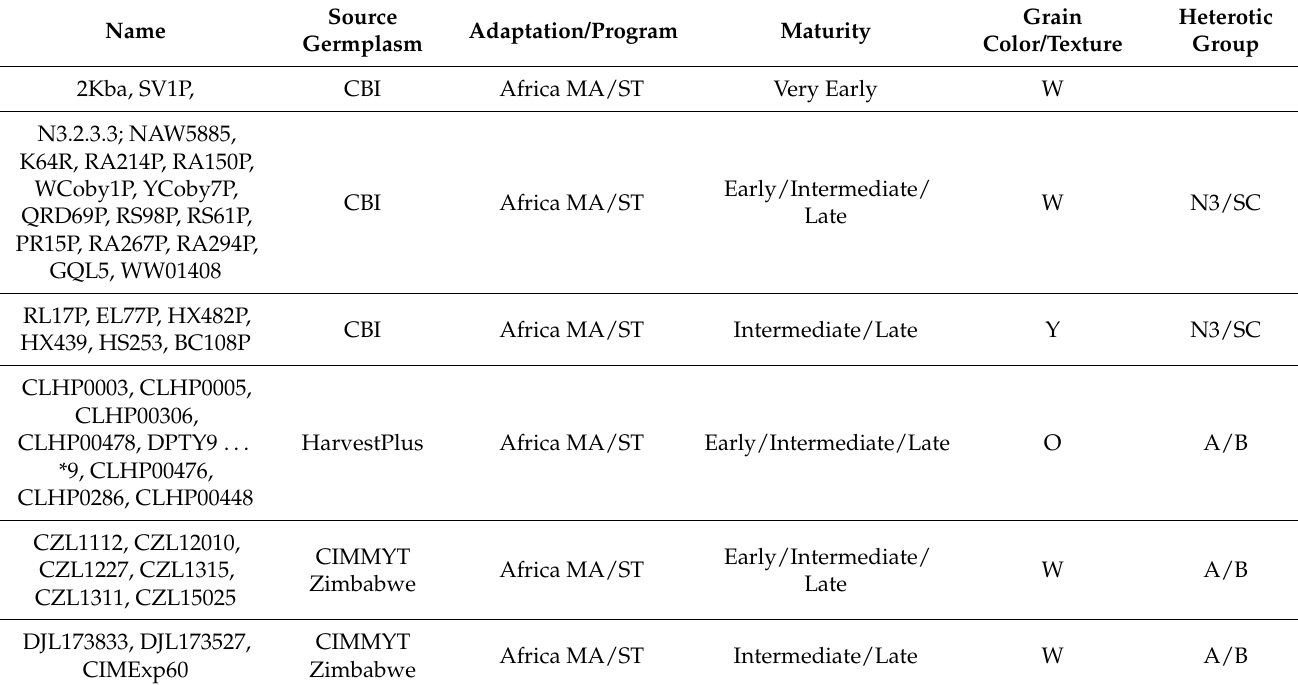
Table 2. Description of inbred lines evaluated for fall armyworm tolerance in